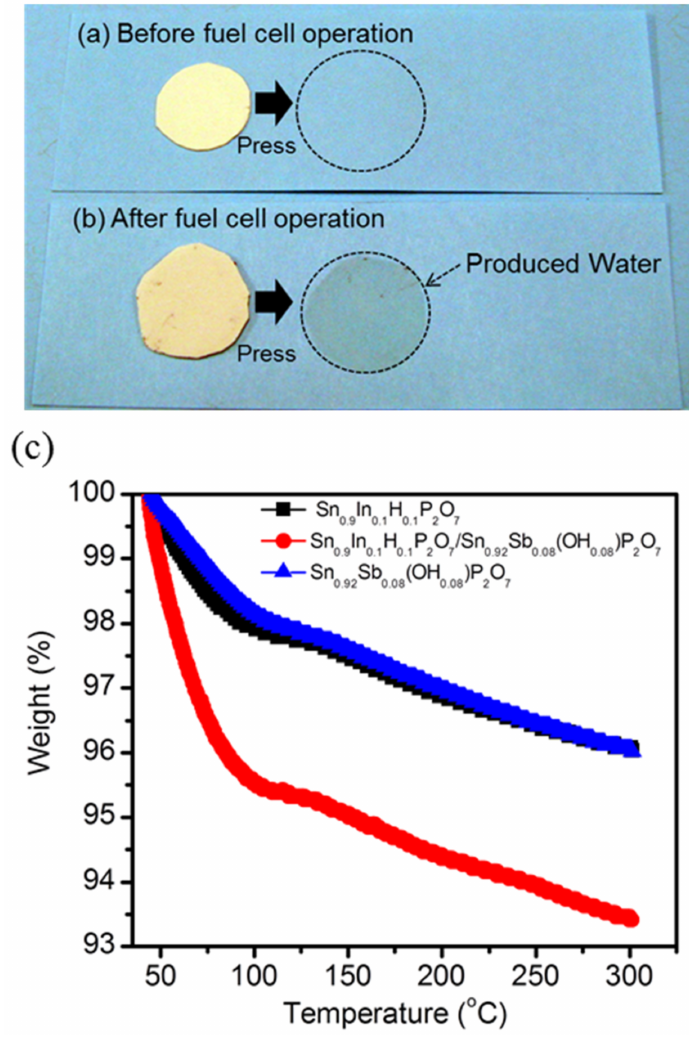
Figure 3. Photo images of water transfer from Sn 0.9 In 0.1 H 0.1 P 2 O 7 /Sn 0.92 Sb 0.08 (OH) 0.08 P 2 O 7 mem- brane to clean paper; ( a ) before and ( b ) after fuel cell operation. Dotted circle lines indicate change of clean paper by produced water after pressing the membranes. ( c ) TGA profiles of